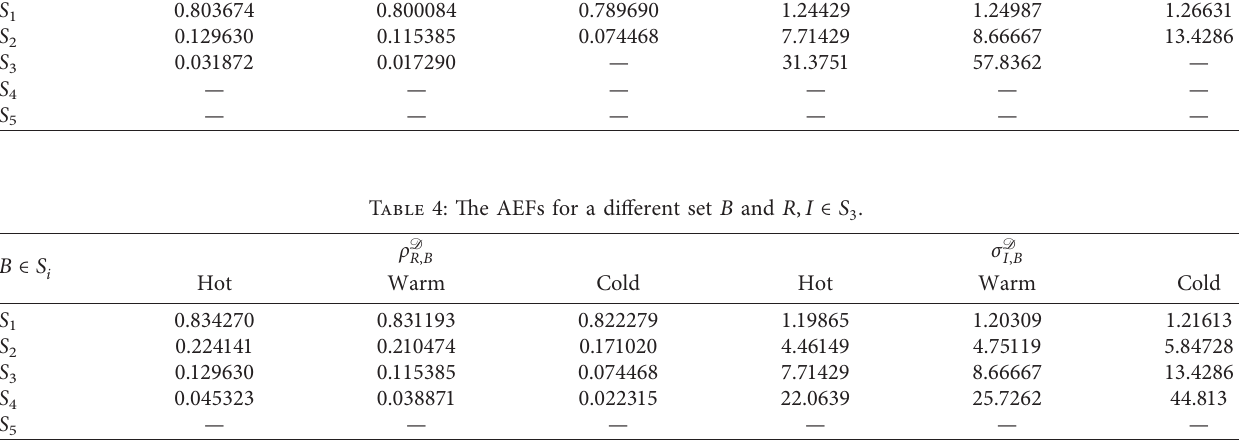
Table 5: The AEFs for a different set B and R,I ∈ S